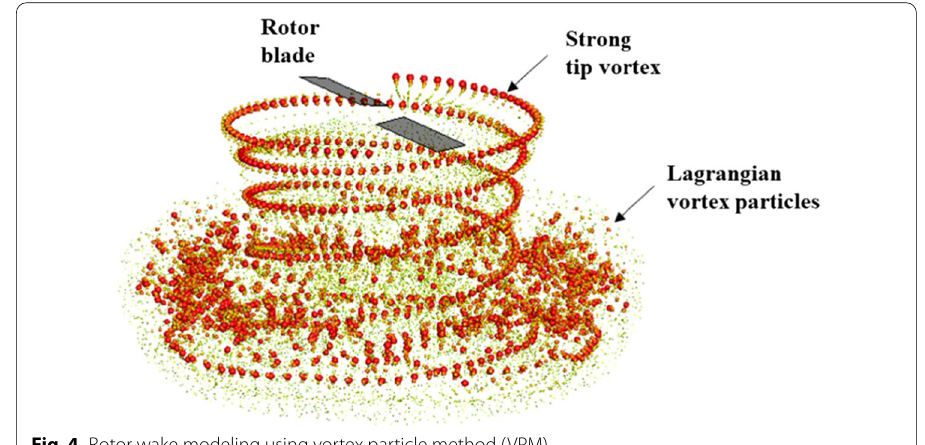
Fig. 4 Rotor wake modeling using vortex particle method